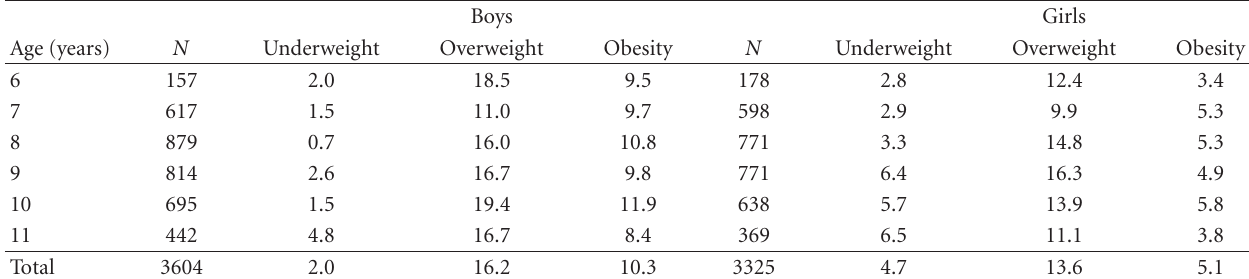
Table 1: The prevalence of overweight and obesity in Chinese children aged 6–11 years by gender and age (%).